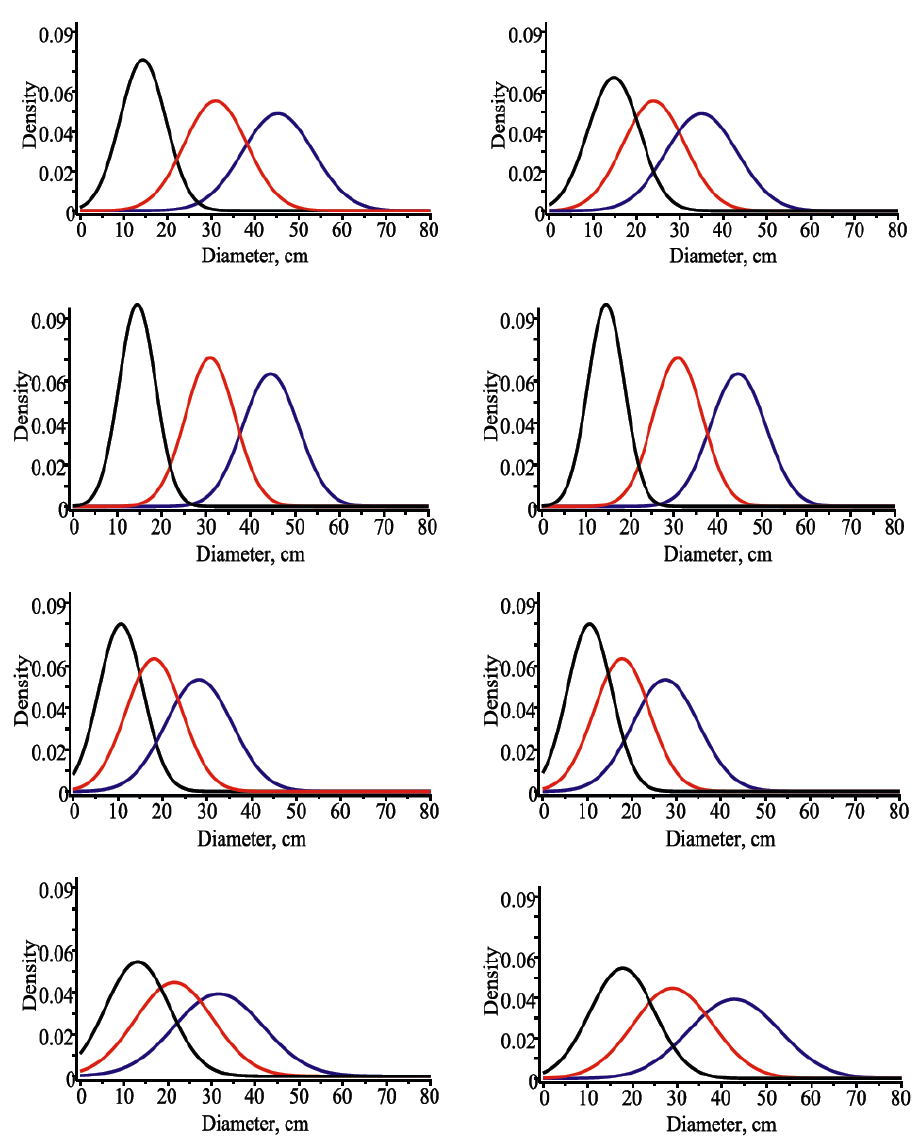
Figure A1. Estimated marginal probability density functions of the diameter for two randomly selected stands from a validation dataset: ( left ) first stand; ( right ) second stand; ( 1st row ) all species; ( 2nd row ) pine ( Pinus sylvestris ); ( 3rd row ) spruce ( Picea abies) ; ( 4th row ) silver birch ( Betula pendula Roth and Betula pubescens Ehrh.); black—30-year-old stands; red—70-year-old stands; and blue—120-year-old stands.